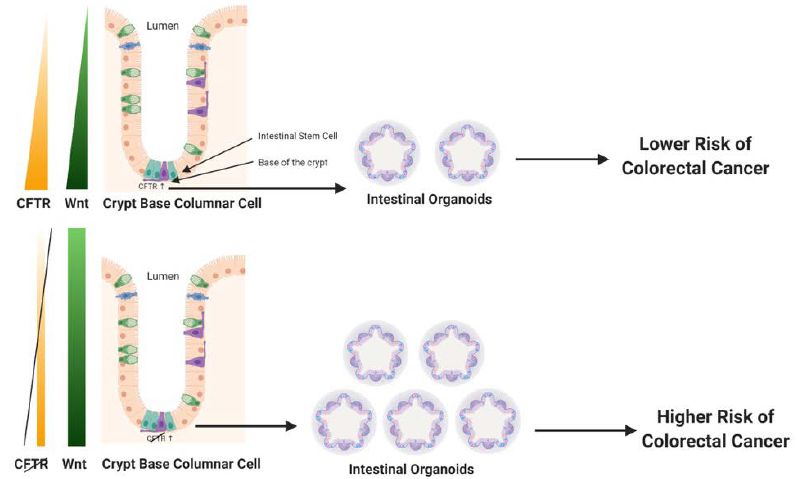
Figure 1. ↓ Cystic fibrosis transmembrane conductance regulator (CFTR) → ↑ Wnt / β -catenin signaling → ↑ proliferation. CFTR deficiency leads to increased cellular response to Wnt / β -catenin signaling and cellular proliferation. For example, CFTR deficiency enhances survival of colon organoids from CFTR knockout (KO) mice [5]. Increases in Wnt / β -catenin signaling is a hallmark of colorectal cancer (CRC) development. Figure created using BioRender.com.